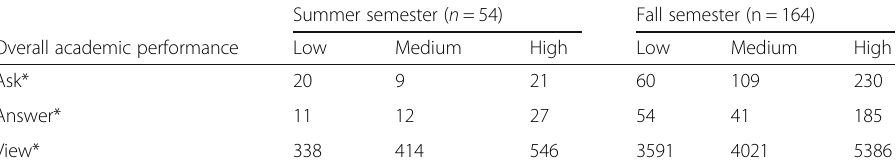
Table 3 Results of social network analysis on online Q & A Summer semester ( n = 54)